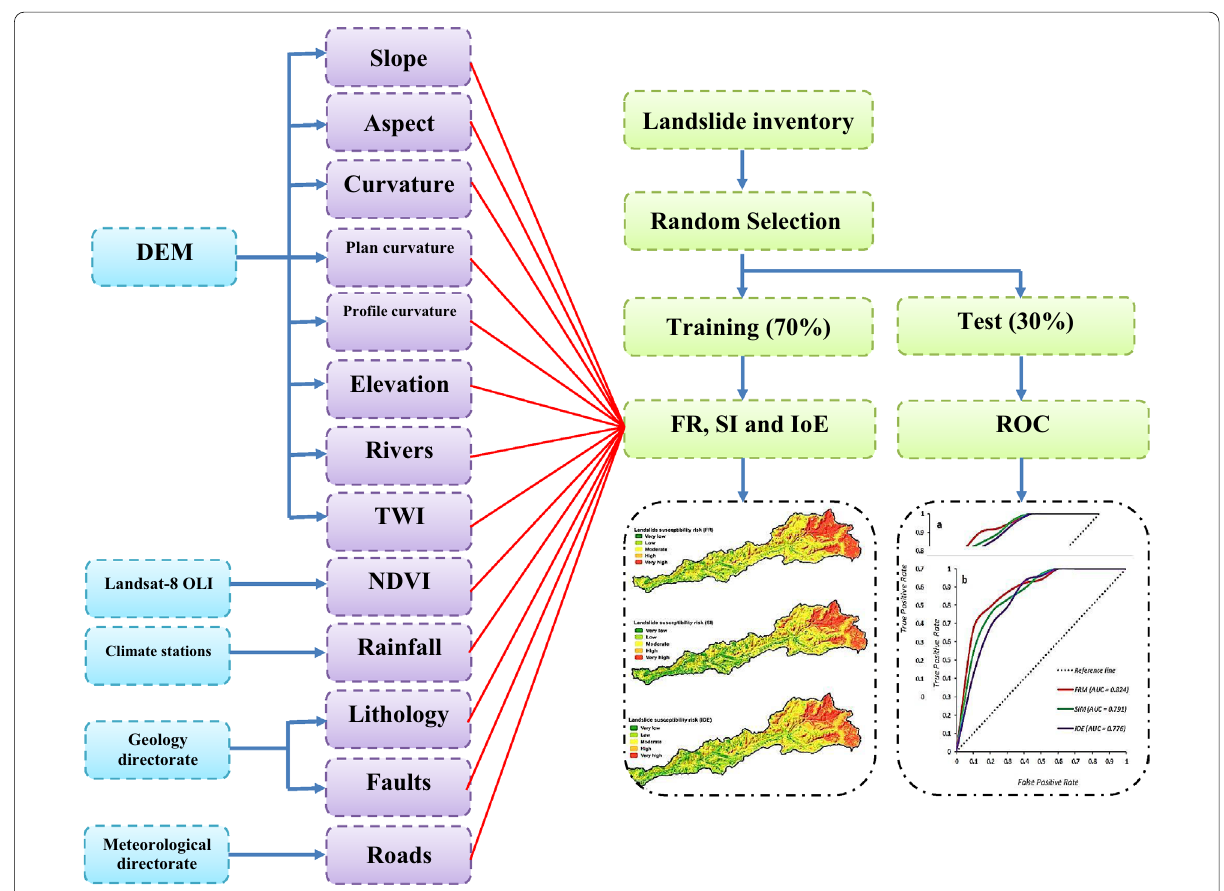
Fig. 2 Flowchart of the applied methodology